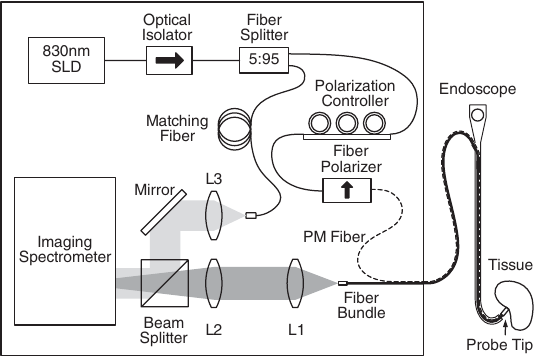
Fig. 2. System configuration of clinical Fourier-domain a/LCI sys- tem. Adapted from Ref.